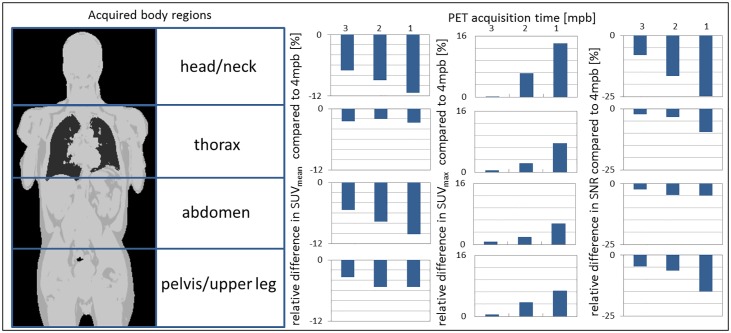
Image quality parameters in different body regions.Overview over the average standard-uptake-values (SUVs) SUVmean, SUVmax and the signal-to-noise ratio (SNR) for four different body regions (head/neck, thorax, abdomen, pelvis/upper legs). The relative difference in % is given for 3, 2 and 1 min per bed (mpb) PET acquisition time in comparison to 4 mpb serving as the reference standard. The impact of reduced PET acquisition times on image quality and quantification parameters is lower for the thorax and pelvic body regions.